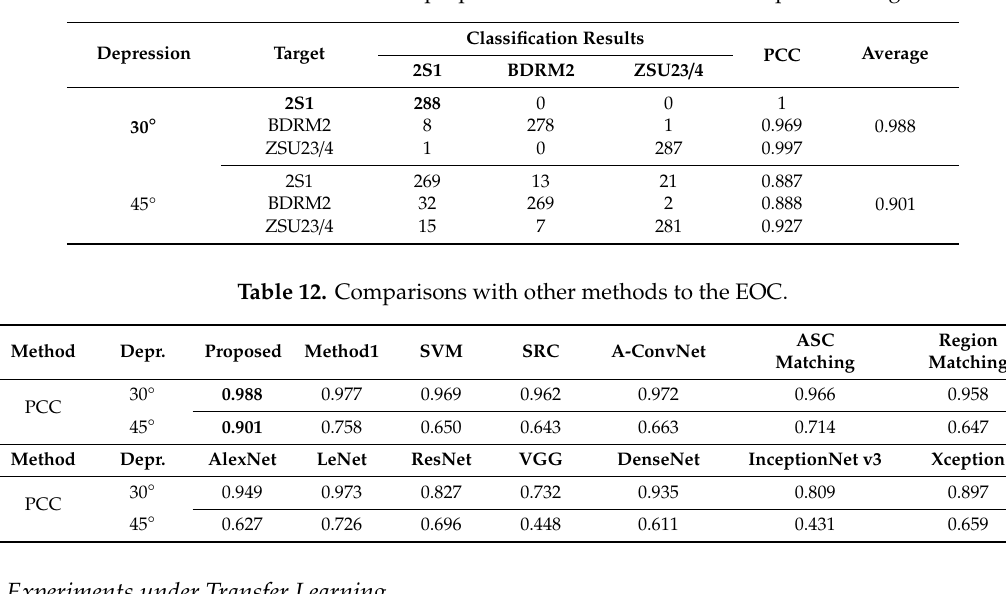
Table 11. Classification results of proposed method at 30 ◦ and 45 ◦ depression angles.